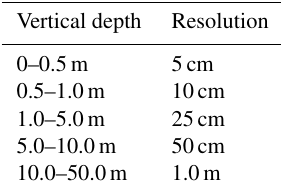
Table 2. Mesh resolution in vertical column. Finer resolution was used in the layers closer to the surface, while a coarser resolution was used in deeper soils.